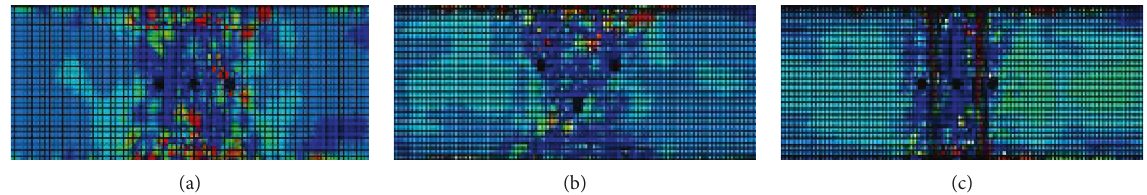
Figure 15: Mises stress nephogram of roof section in the next 0.45ms after blasting. (a) “Straight-line” blasting layout. (b) “Triangle-fractal” blasting layout. (c) “Deep-shallow-fractal” blasting